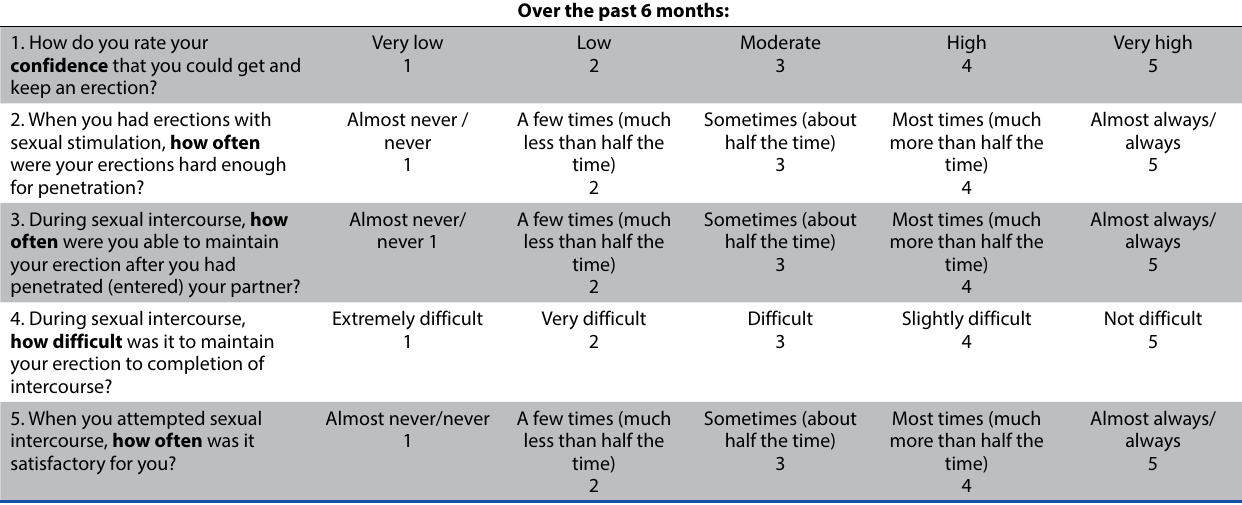
Table II: The International Index of Erectile Function (IIEF-5) Questionnaire 11